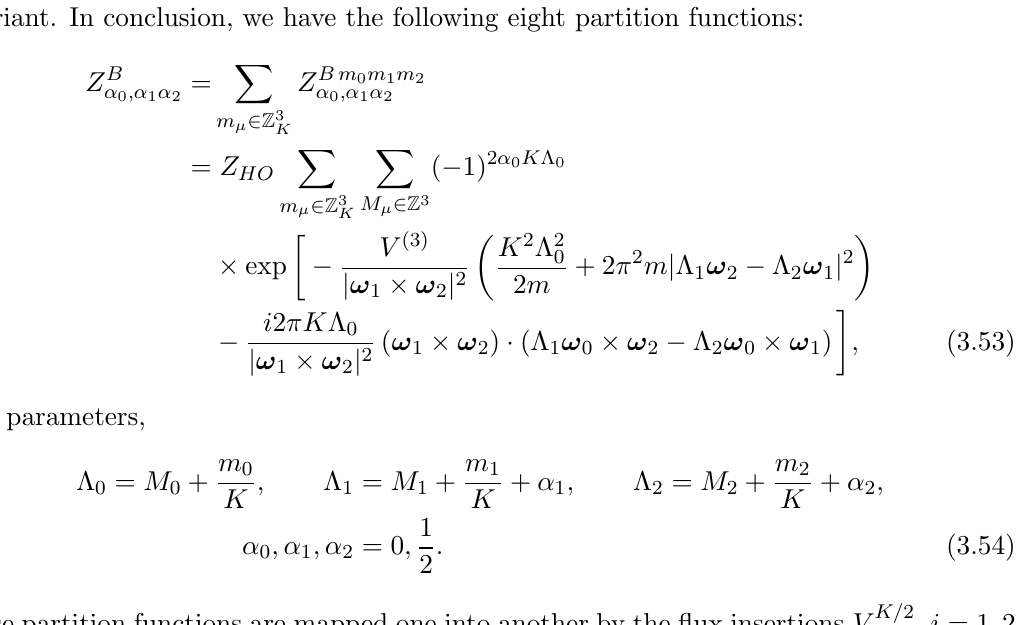
(cid:11) 0 ;(cid:11) 1 (cid:11) 2